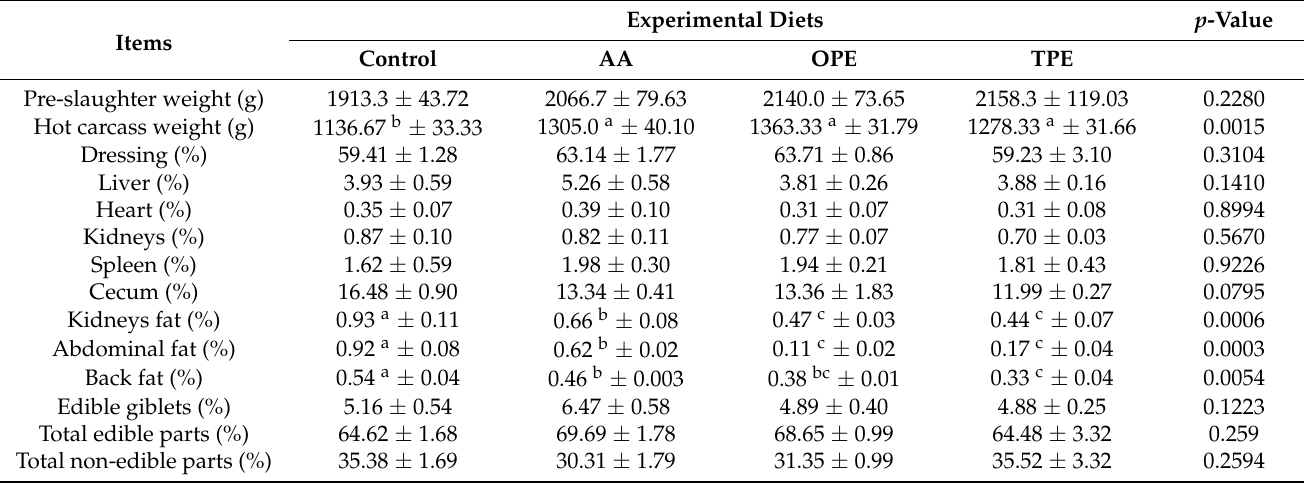
Table 4. Effect of dietary supplementation of AA, OPE and TPE on carcass characteristics of growing rabbits at 13 weeks of